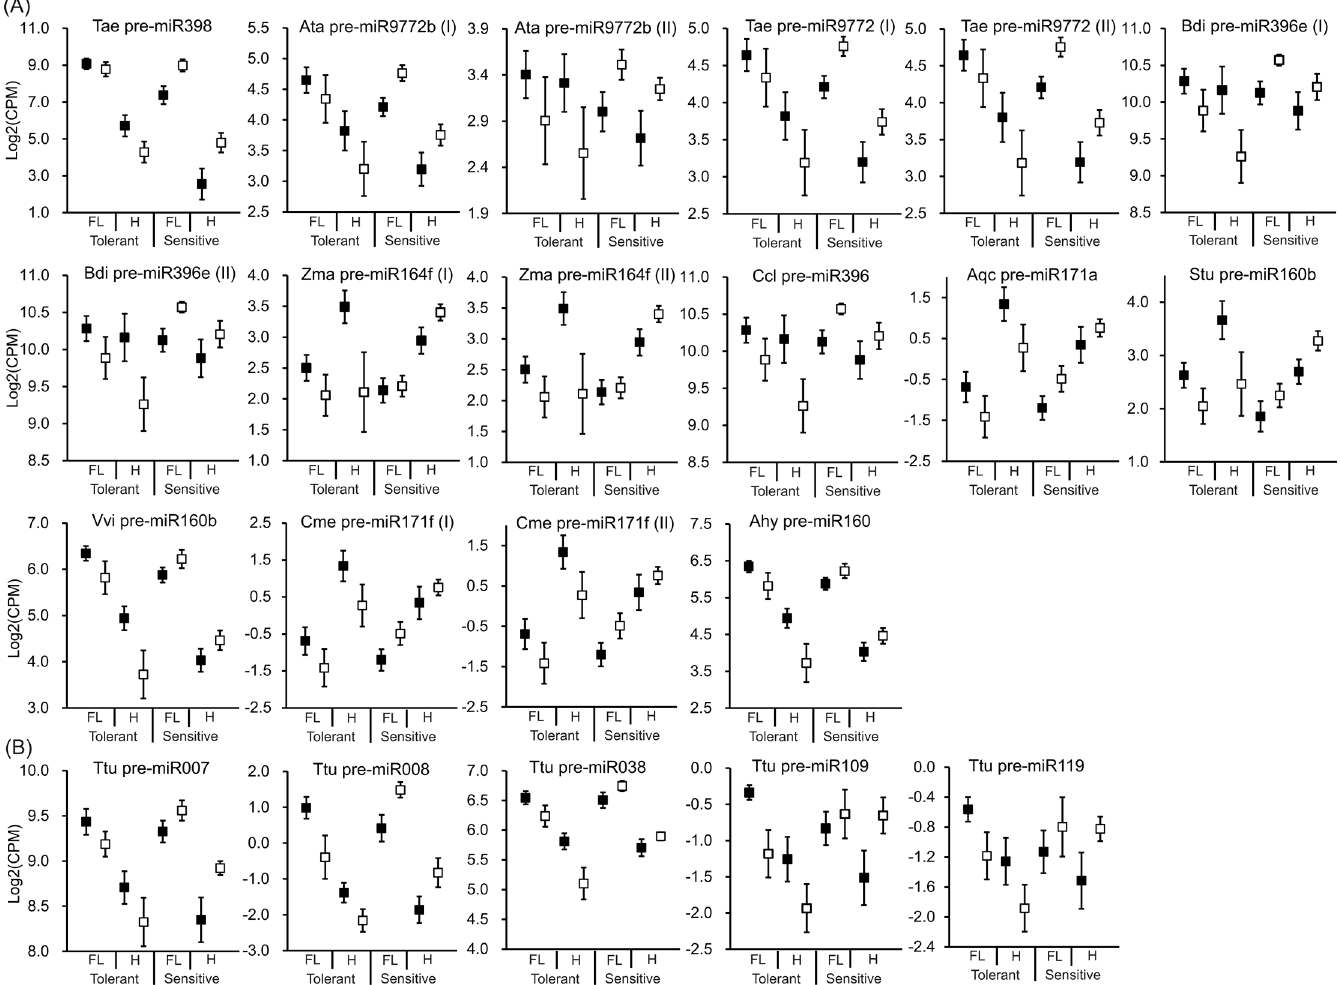
Fig 6. Expression profiles of stress responsive miRNA hairpins showing inverted regulatory patterns between stress tolerant/sensitive genotypes. In (A) 16 conserved miRNA hairpins representing 11 conserved miRNAs are shown, while in (B) five novel miRNA hairpins representing four conserved miRNAs are displayed. The log2 value of normalised reads for each miRNA hairpin is represented as counts per million (CPM). & = Control group; □ = Water deficit stress group. Tae = Triticum aestivum ; Ata = Aegilops tauschii ; Bdi = Brachypodium distachyon ; Zma = Zea mays ; Ccl = Citrus clementina ; Aqc = Aquilegia coerulea ; Stu = Solanum tuberosum ; Vvi = Vitis vinifera ; Cme = Cucumis melo ; Aty = Arachis hypogaea ; Tolerant = Stress tolerant genotypes (Tamaroi and Yawa); Sensitive = Stress sensitive genotypes (EGA Bellaroi and Tjilkuri); I and II denotes two different hairpins representing the same conserved